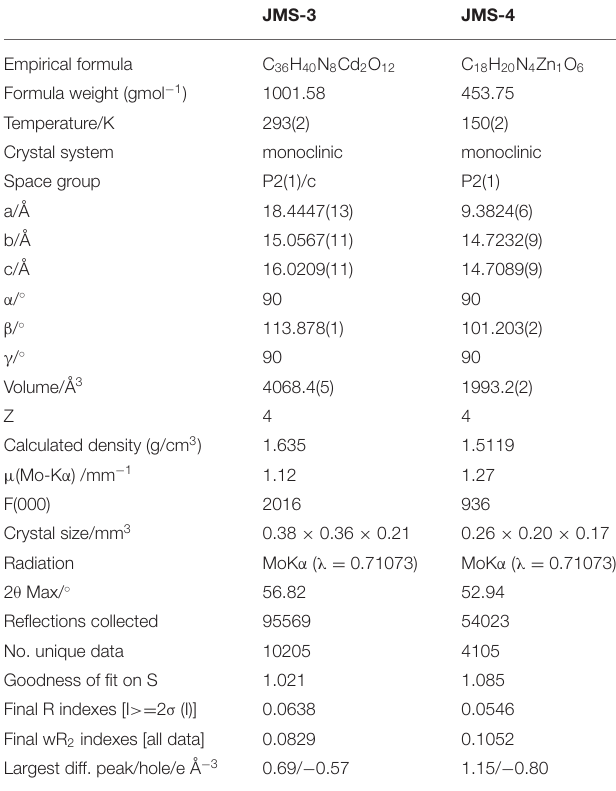
TABLE 1 | Crystal data and refinement parameters for JMS-3 and